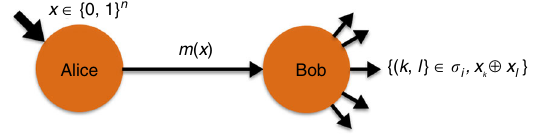
Fig. 1 The Sampling Matching problem. Alice gets an input x ∈ {0, 1} n and sends a message m ( x ) to Bob who outputs the pair 〈 ( k , l ) ∈ σ i , b = x k ⊕ x l 〉 for a matching σ i , whose distribution is uniform in M , even conditioned on m ( x ). The parity should be correct with high probability for all choices of